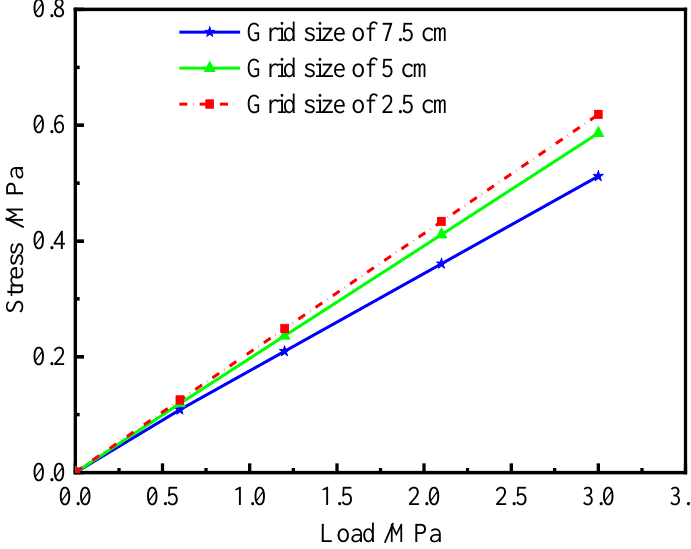
Figure 11. Interface shear stress.